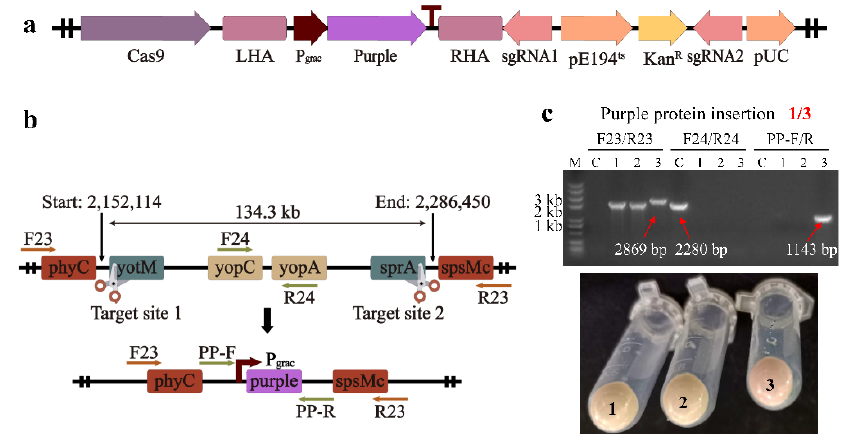
Figure 6. Stable expression of the purple protein in the genome ( a ) The operon P grac -purple was inserted between the left homologous arm (LHA) and the right homologous arm (RHA) and inte- grated into the genome by HDR. ( b ) The purple protein was integrated into the original genome at the location of a 134.3 kb long fragment. ( c ) Purple protein was successfully inserted into the genome of colony No. 3 and expressed, as verified by PCR results and the color of colonies.